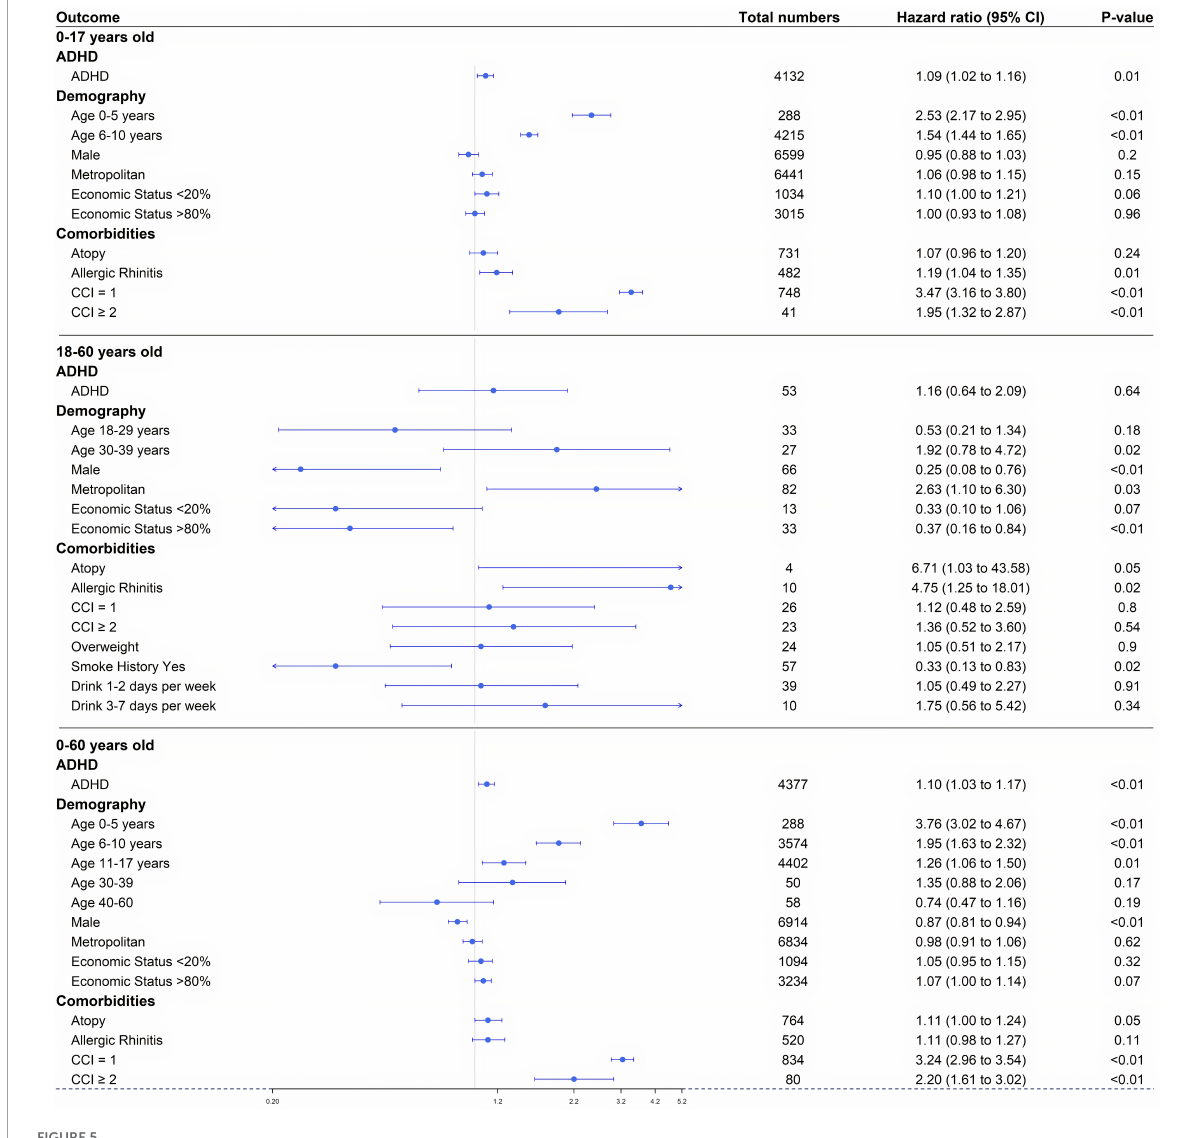
FIGURE5 Study 2. Forest plot of adjusted hazard ratio for each factor in a multivariate Cox proportional hazard model for three age groups (0–17, 18–60, and 0–60 years): ADHD, sex, economic status, age, residential area, underlying disease (atopic dermatitis, allergic rhinitis), and Charlson comorbidity index. CCI, Charlson comorbidity